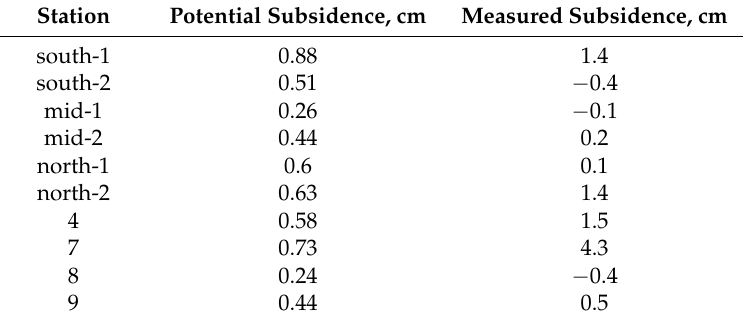
Table 2. Potential subsidence due to volumetric change in soil pores and actual subsidence measured in July 2013. Negative values represent uplift, which can be explained by either growing vegetation or uncertainties inherent in the manual measurements. Station Potential Subsidence, cm Measured Subsidence,